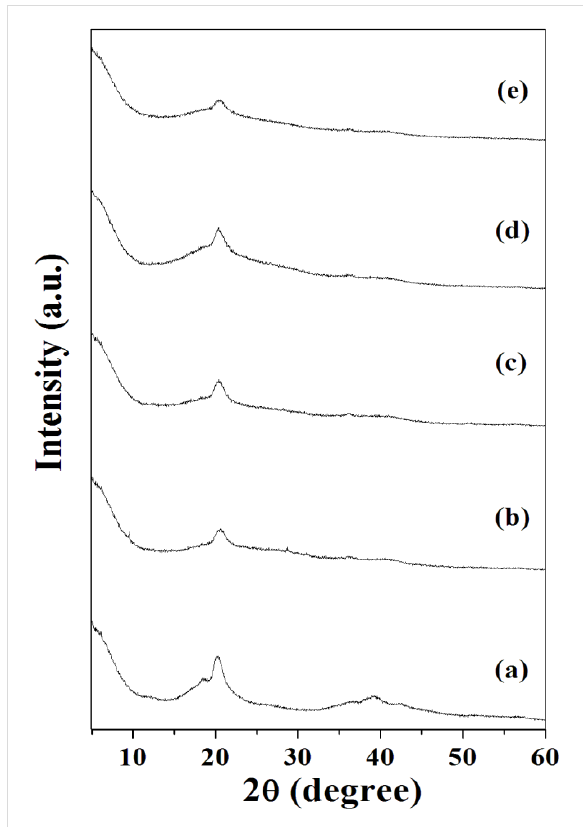
Figure 2: XRD spectra of (a) a pure PVdF-HFP film, (b) {(PVdF-HFP)- [BDiMIM][Cl]} (4:6), (c) {(PVdF-HFP)-[BDiMIM][Cl]} (3:7), (d) ({(PVdF- HFP)-[BDiMIM][Cl]} (4:6)) (20 wt %) + [PC-Mg(ClO 4 ) 2 (0.3 M)] (80 wt %), and (e) ({(PVdF-HFP)-[BDiMIM][Cl]} (4:6)) (30 wt %)